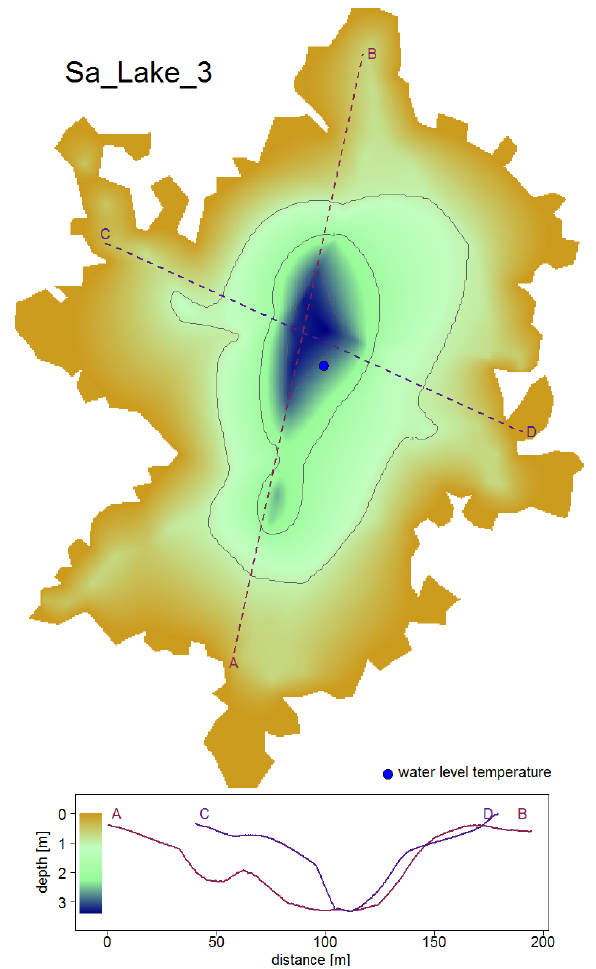
Figure A3. Bathymetry and cross sections of Sa_Lake_3 with loca- tion of sensors.